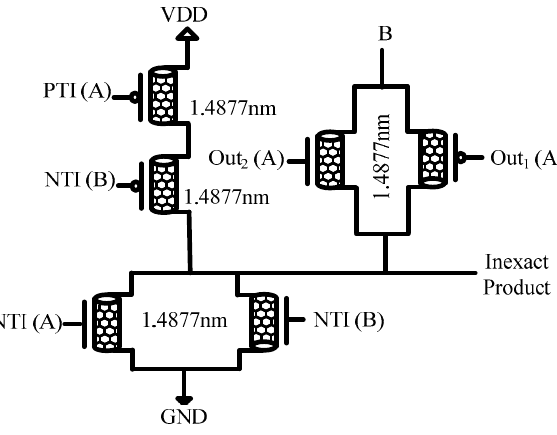
Figure 6. Schematic design of the second proposed inexact design.